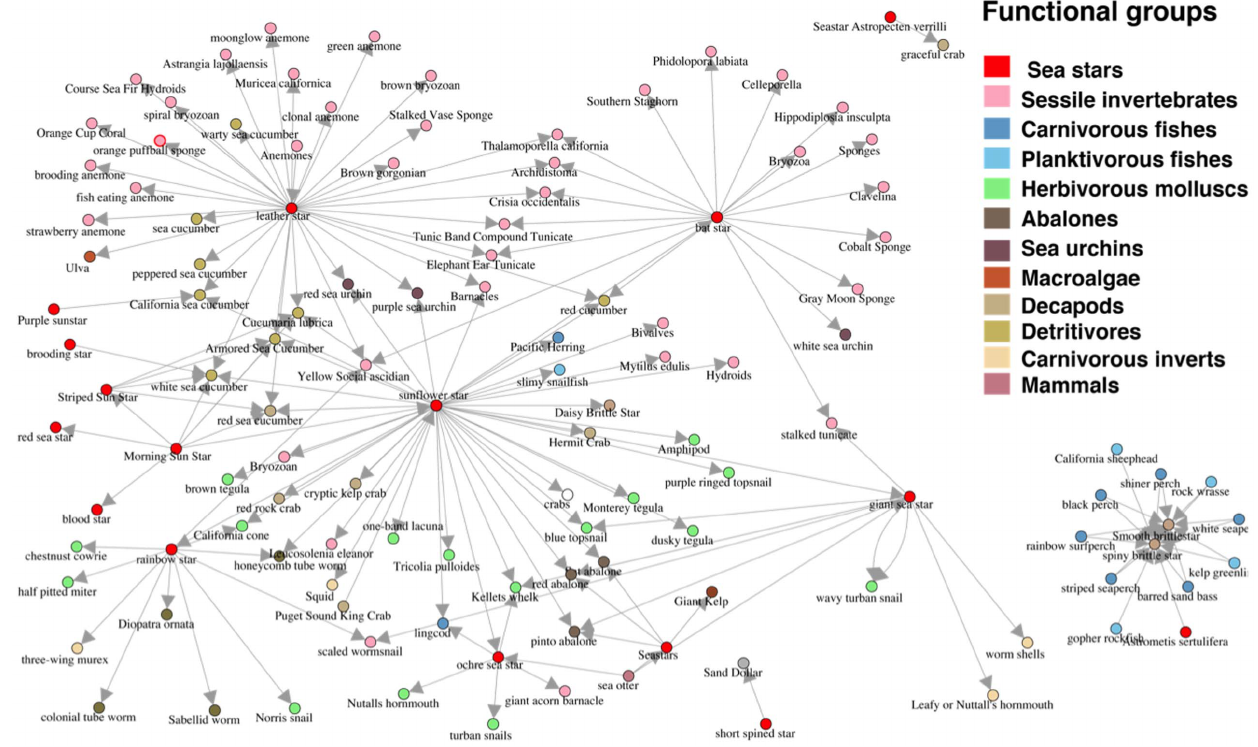
Figure 3. Example of the database visualization tool illustrating a trophic interaction network for an assemblage of kelp forest seastars, color-coded by functional group after Graham etal. [25].